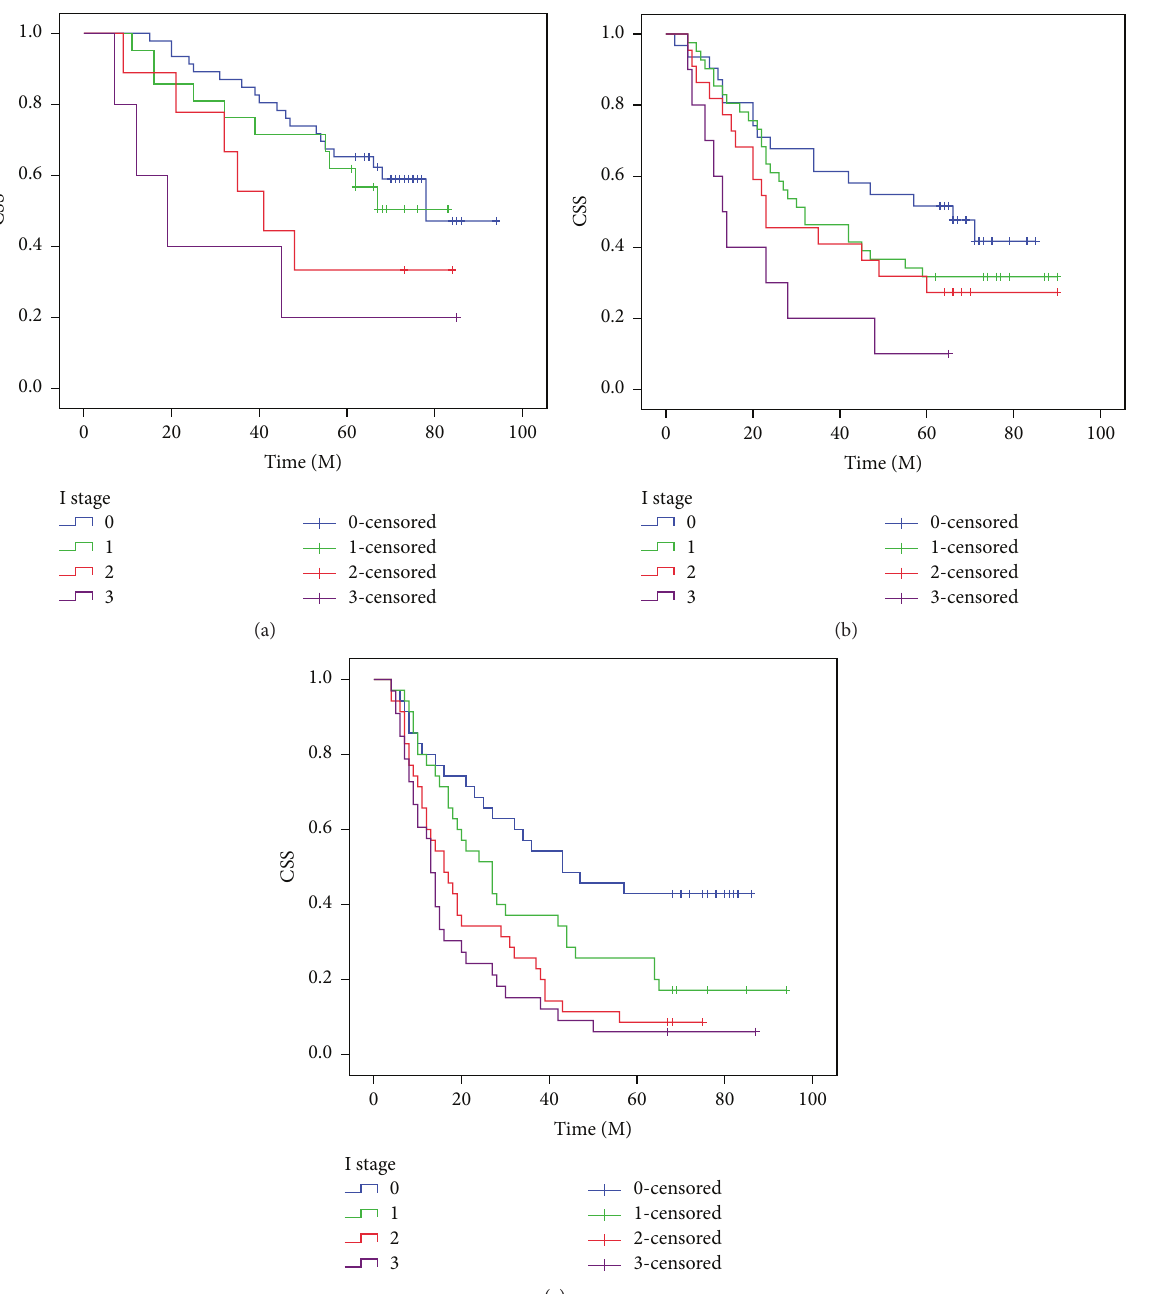
Figure 6: The predictive values of I stage were significant in patients based on TNM stage. TNM I stage ( 𝑃 = 0.035 , (a)), TNM II stage ( 𝑃 = 0.028 , (b)), and TNM III stage ( 𝑃 < 0.001 ,